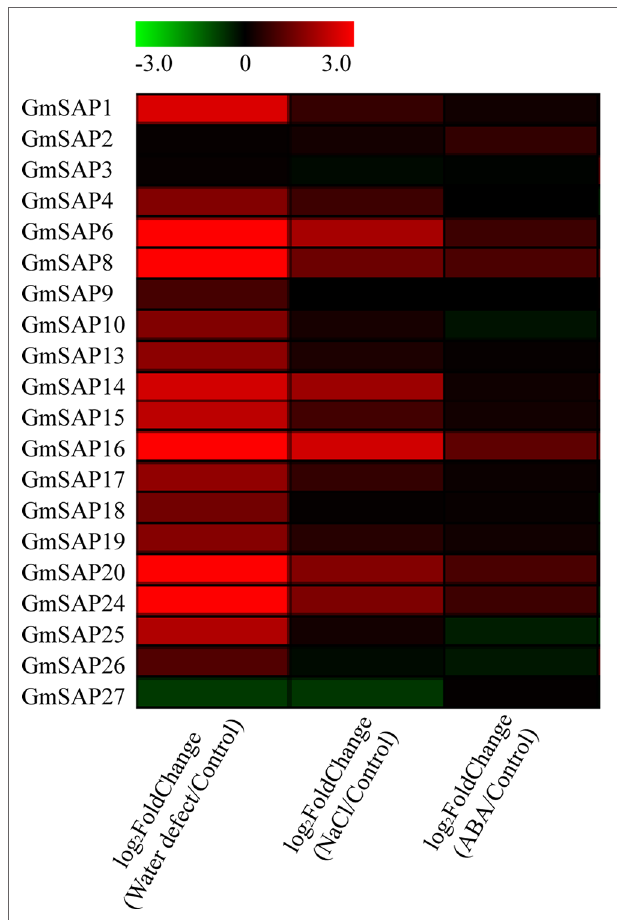
FiGURe 4 | RNA-seq analysis of the soybean stress associated protein (SAP) genes under water deficit, salt, and abscisic acid (ABA) treatments. RNA-seq data were extracted from our previous research (Shi et al., 2018). The heatmap was produced by MeV_4_9_0 software, and different colors on the scale bar represent transcript